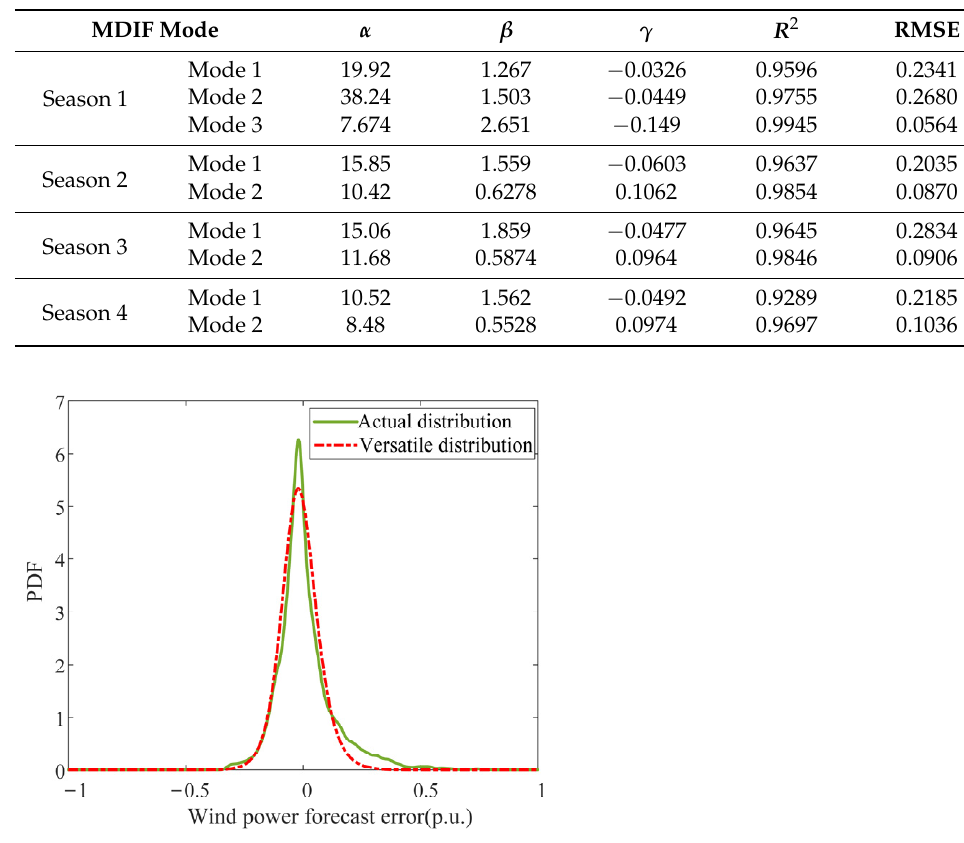
Table 2. Fitting and evaluation results of versatile distribution of WPFE.